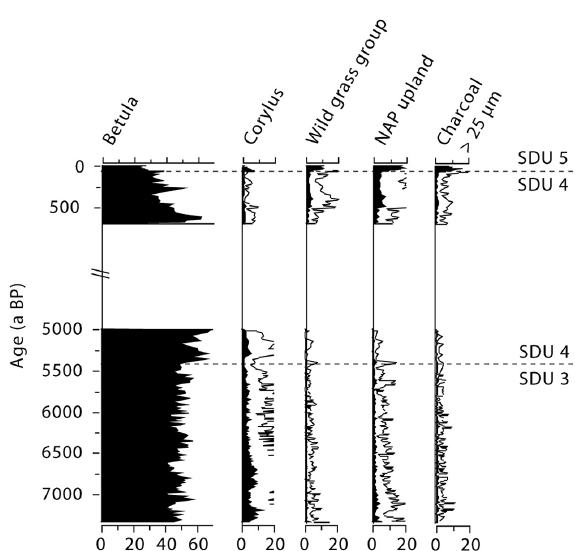
Figure 6. Pollen records from Lake Kälksjön (KKJ) sediments cov- ering the transitions between SDUs 3 and 4, as well as SDUs 4 and